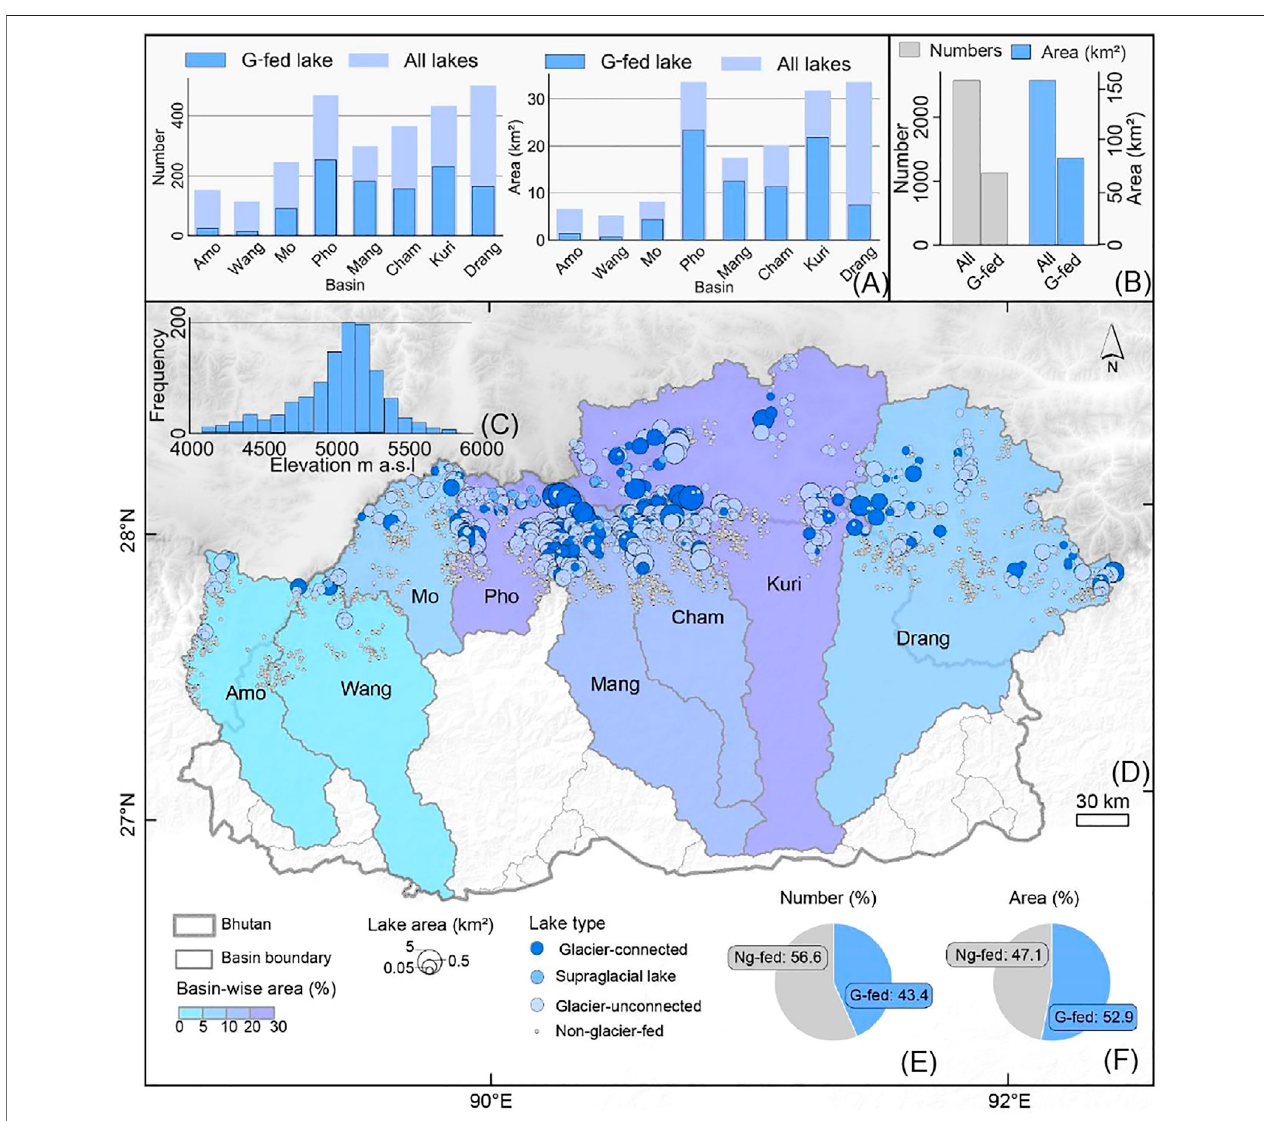
FIGURE 3 | Distribution of glacial lakes in the Bhutan Himalaya in 2020. The bars display the proportion of all lakes and glacier-fed (G-fed) lakes across the eight basins (A) and in the entire BTH (B) . The histogram (C) indicates the distribution of glacier-fed lakes with altitude. The map (D) compares the total area of the glacial-fed lakes (%) among the eight basins and the distribution of non-glacier-fed and different types of glacier-fed lakes based on their size. Pie charts show the percentage ratio of glacier-fed lakes to nonglacial-fed in number (E) and area (F) .